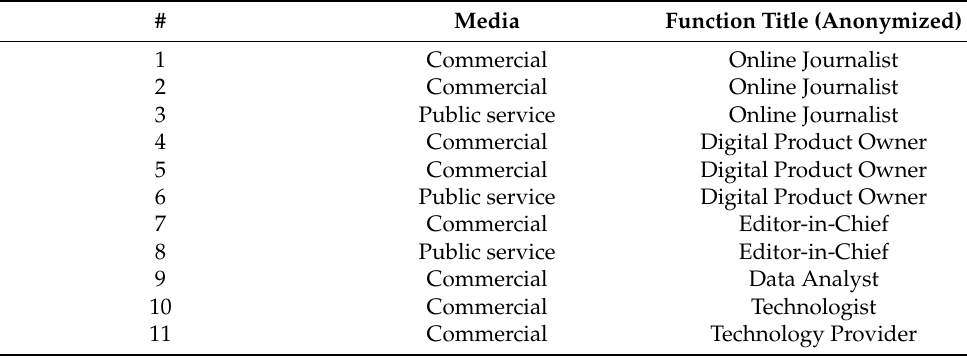
Table A1. Anonymized list of interviewees, type of media and